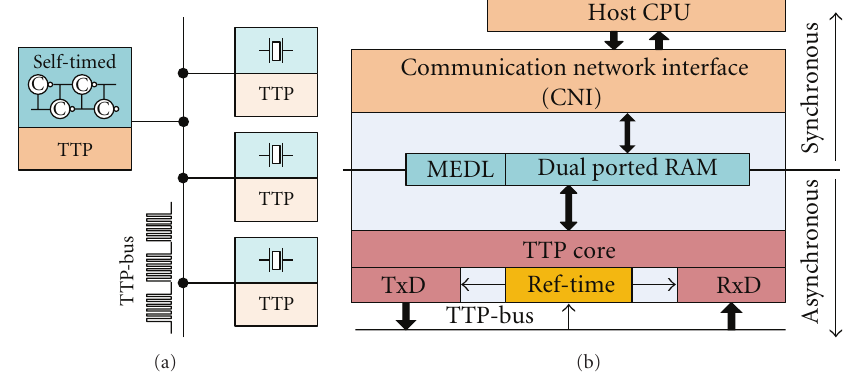
Figure 2: ARTS system setup (a) and TTP-node block diagram